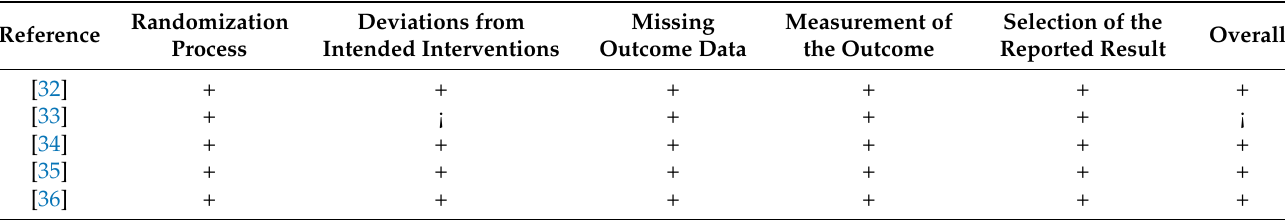
Table 3. Risk of bias of the five randomized controlled trials that were selected. Randomization Deviations from Reference Process Intended Interventions